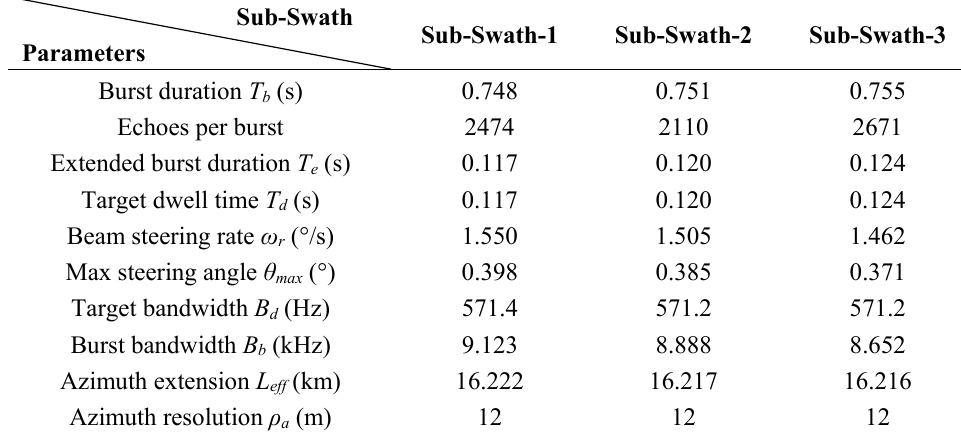
Table 5. Parameters of different sub-swaths in Extended Terrain Observation by Progressive Scans